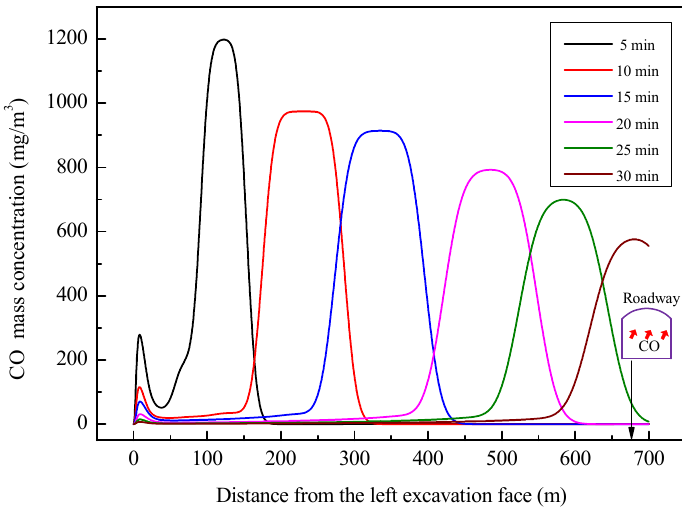
Figure 10. CO mass concentration distribution in the central axial plane. ( a ) Ventilation for 5 min; ( b ) Ventilation for 10 min; ( c ) Ventilation for 15 min; ( d ) Ventilation for 20 min; ( e ) Ventilation for 25 min; ( f ) Ventilation for 30 min.